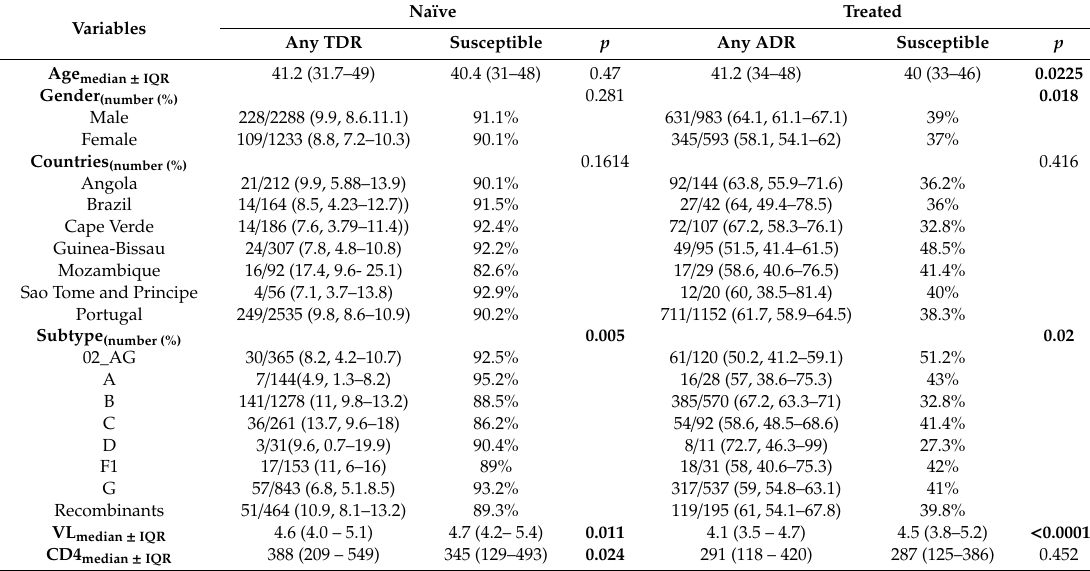
Table 3. Characteristics of naïve-treated patients versus treated patients.